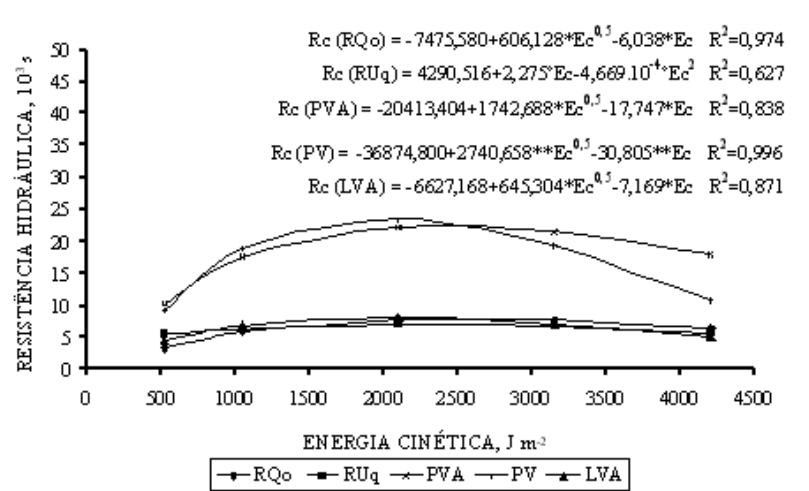
Figura 5. Resistência hidráulica da crosta (Rc), considerando a energia cinética aplicada (Ec) e a classe de solo (**, * e ° significativos a 1, 5 e 10 %, respectivamente, pelo teste t). Sendo: PV = Argissolo Vermelho; PVA = Argissolo Vermelho-Amarelo; LVA = Latossolo Vermelho-Amarelo; RUq = Neossolo Flúvico; e RQo = Neossolo